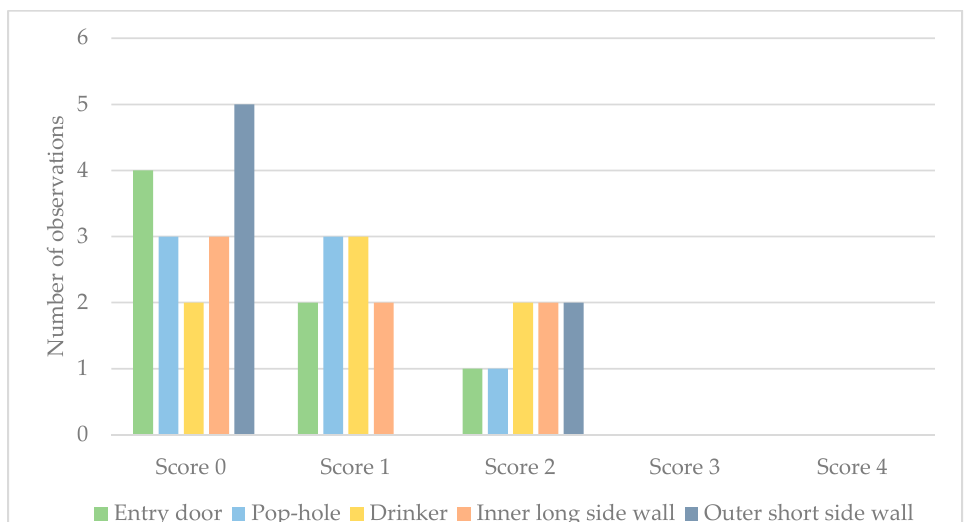
Figure 3. Litter quality assessment scores (Welfare Quality ® ) for Swedish organic broiler farms ( n = 7): number of observations ( n = 35) with score 0–4 at five standardised locations in rearing compartments.